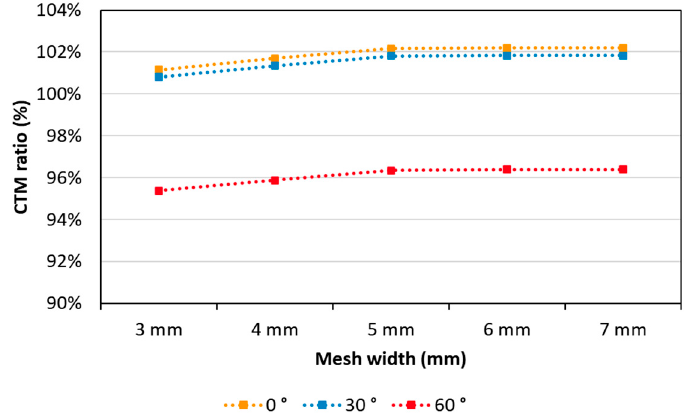
Figure 15. CTM ratio depending on coated area.